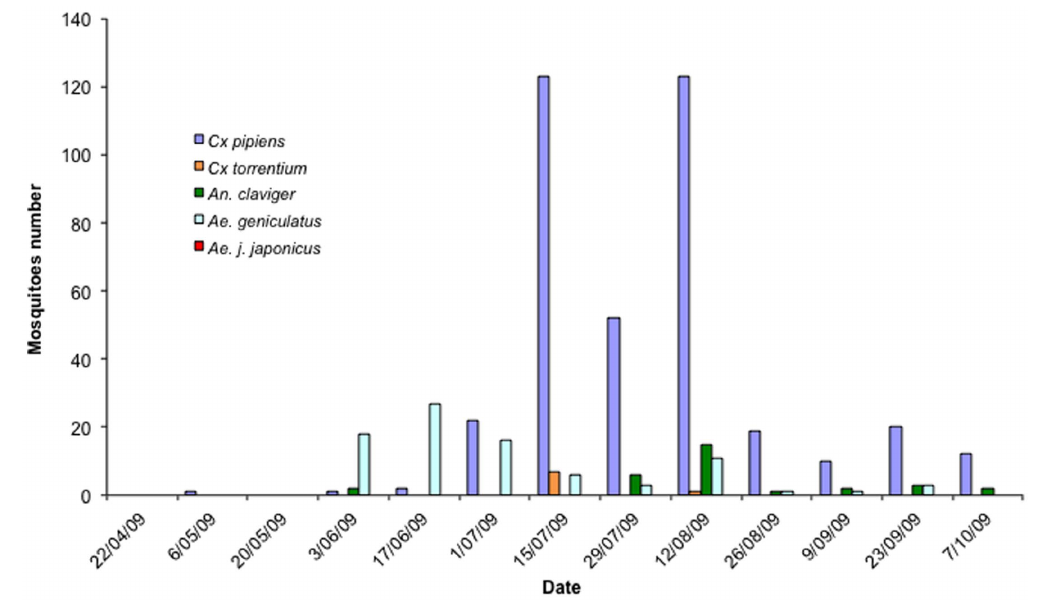
Figure 3. Number of adult mosquitoes of the 4 species found in the three kinds of traps during the 13 visits at Natoye 2.